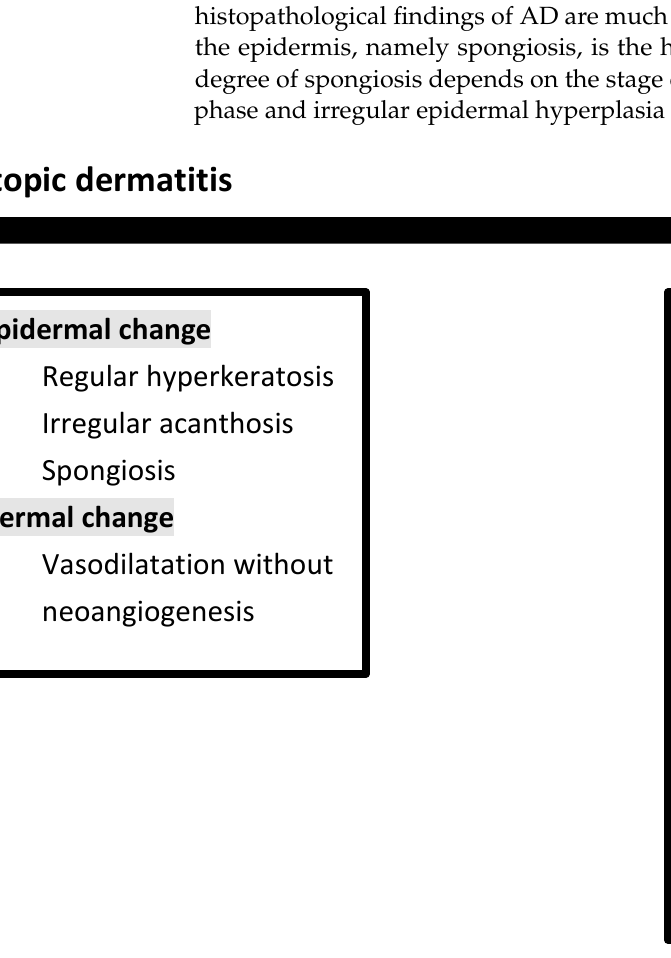
Figure 3. Histopathologic change in between atopic dermatitis and psoriasis.